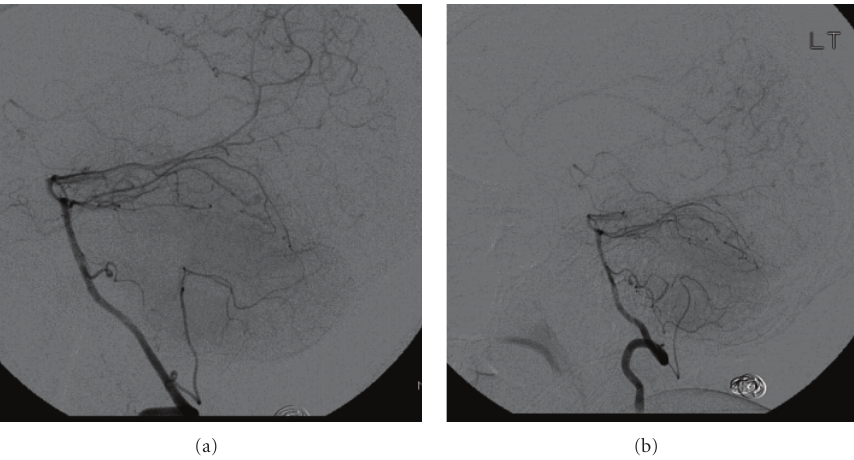
Figure 1: The attached pictures are digitally subtracted images from a cerebral angiogram of our patient. (a) Right vertebral injection showing irregular, serpiginous ill-defined vessels. (b) Left vertebral injection showing similar findings.